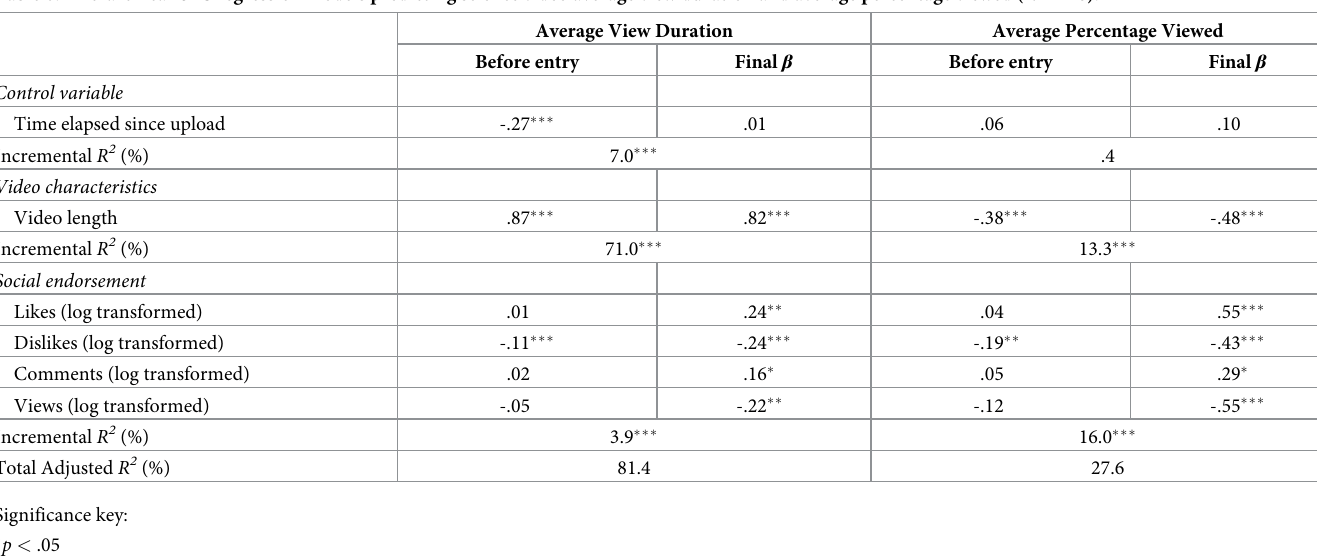
Table 6. Hierarchical OLS regression models predicting science video average view duration and average percentage viewed ( N =